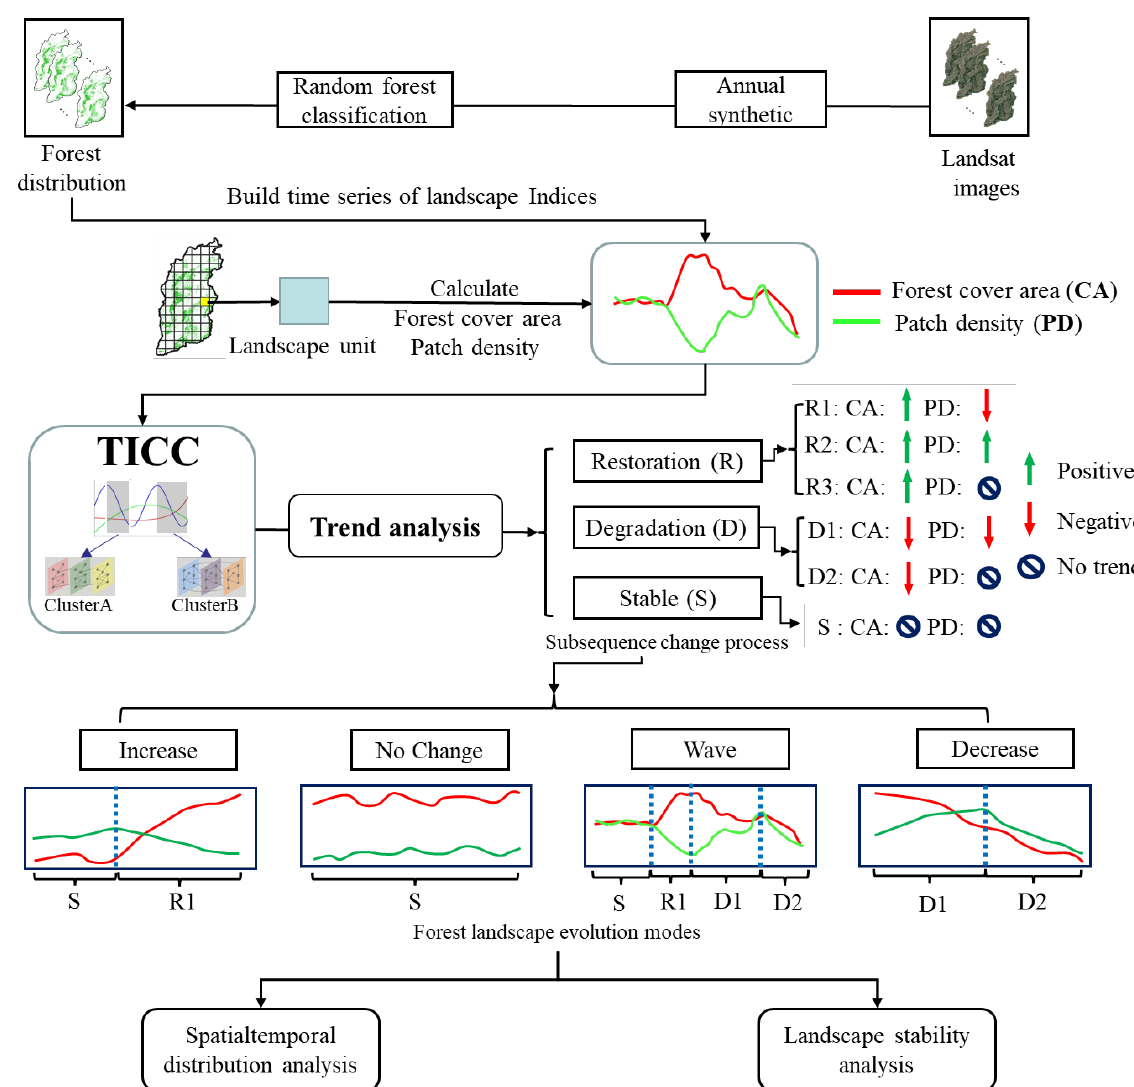
Figure 2. Schematic representation of the research method used in this study.